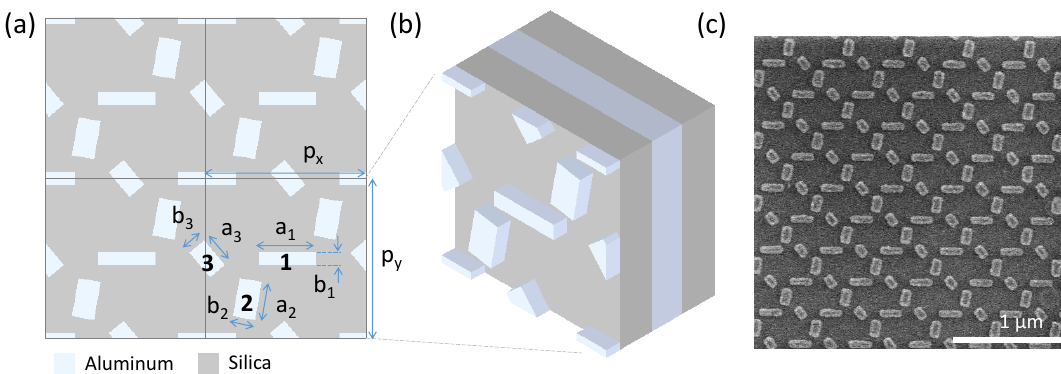
Figure 1. ( a ) Schematic of metasurface and ( b ) its unit cell. It has metal-insulator-metal structure where aluminum and silica are used as metal and insulator respectively on a silica substrate. Thickness of aluminum film, silica film and aluminum rods are 90 nm, 100 nm and 40 nm respectively. Three nanorods numbered by 1, 2 and 3 are periodically arranged and the unit cell has two of each of the nanorods. i -th slit is tilted by φ i where a i and b i denote horizontal and vertical dimension. Geometric parameters indicated in the figure are: p x = 500 nm, p y = 500 nm, a 1 = 180 nm, a 2 = 120 nm, a 3 = 100 nm, microscopy image.